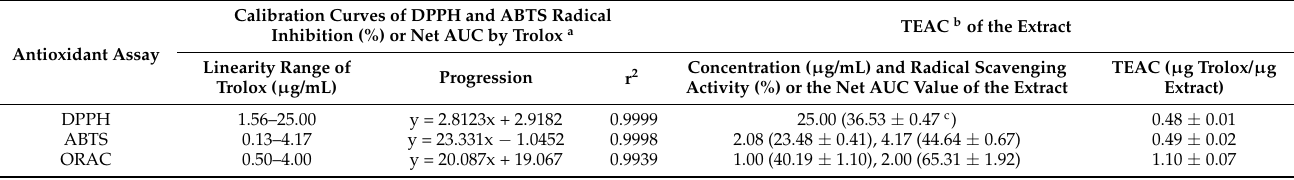
b of the Extract